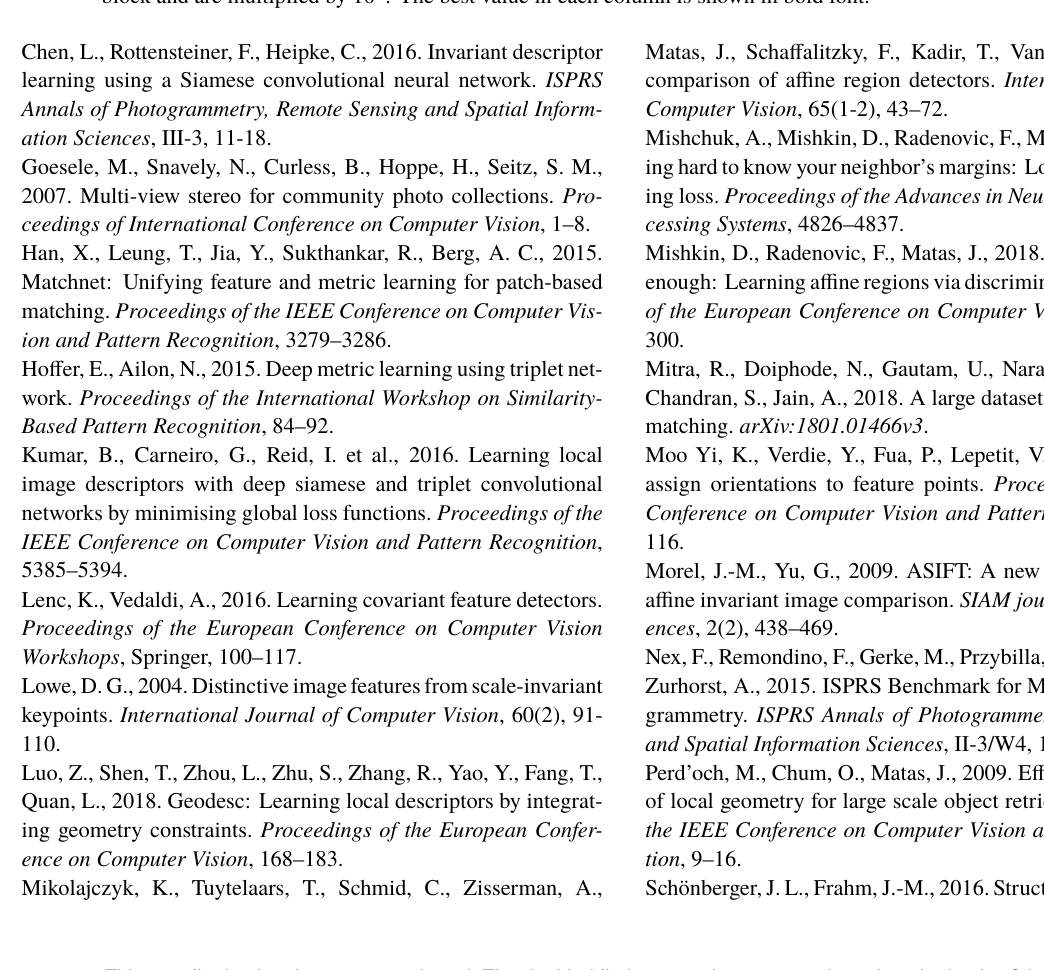
Table 4. The result for all blocks after robust bundle adjustment. #reg. img: number of registered images over available number of images; # rec. pts: number of reconstructed 3D points; m. rpj error [pixel]: mean reprojection error in [pixel]; #gross errors: number of gross errors, which are the matching points have residuals larger than 3.2 times of the standard deviation of adjusted matching points; #m. obs. per img.: number of mean observation per image; RMS values of X,Y,Z refer to the scaling of the block and are multiplied by 10 3 . The best value in each column is shown in bold